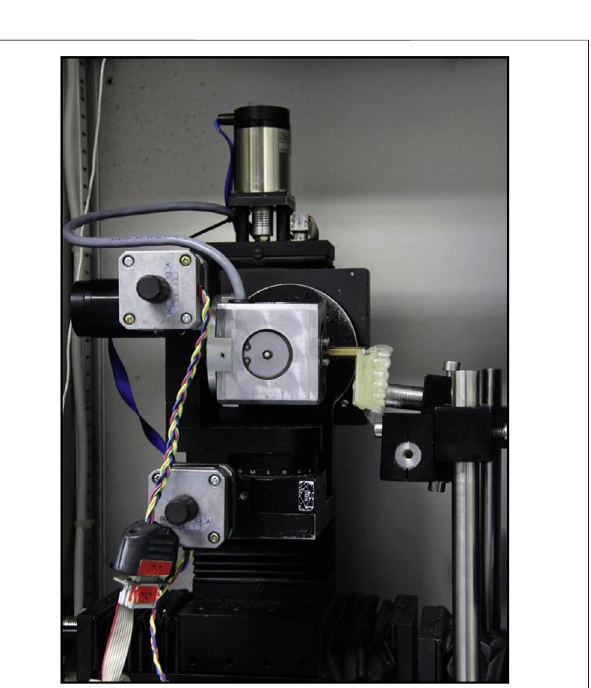
FIGURE5| Orthodonticmeasurementandsimulationsystem(OMSS):a resinreplicawitha4D-printedalignerismountedinthesystem.Tooth21tobe analyzed was connected to a computer-controlled 3D sensor. The measured moments and forces are registered, and the motor-driven positioning table simulates the analyzed tooth